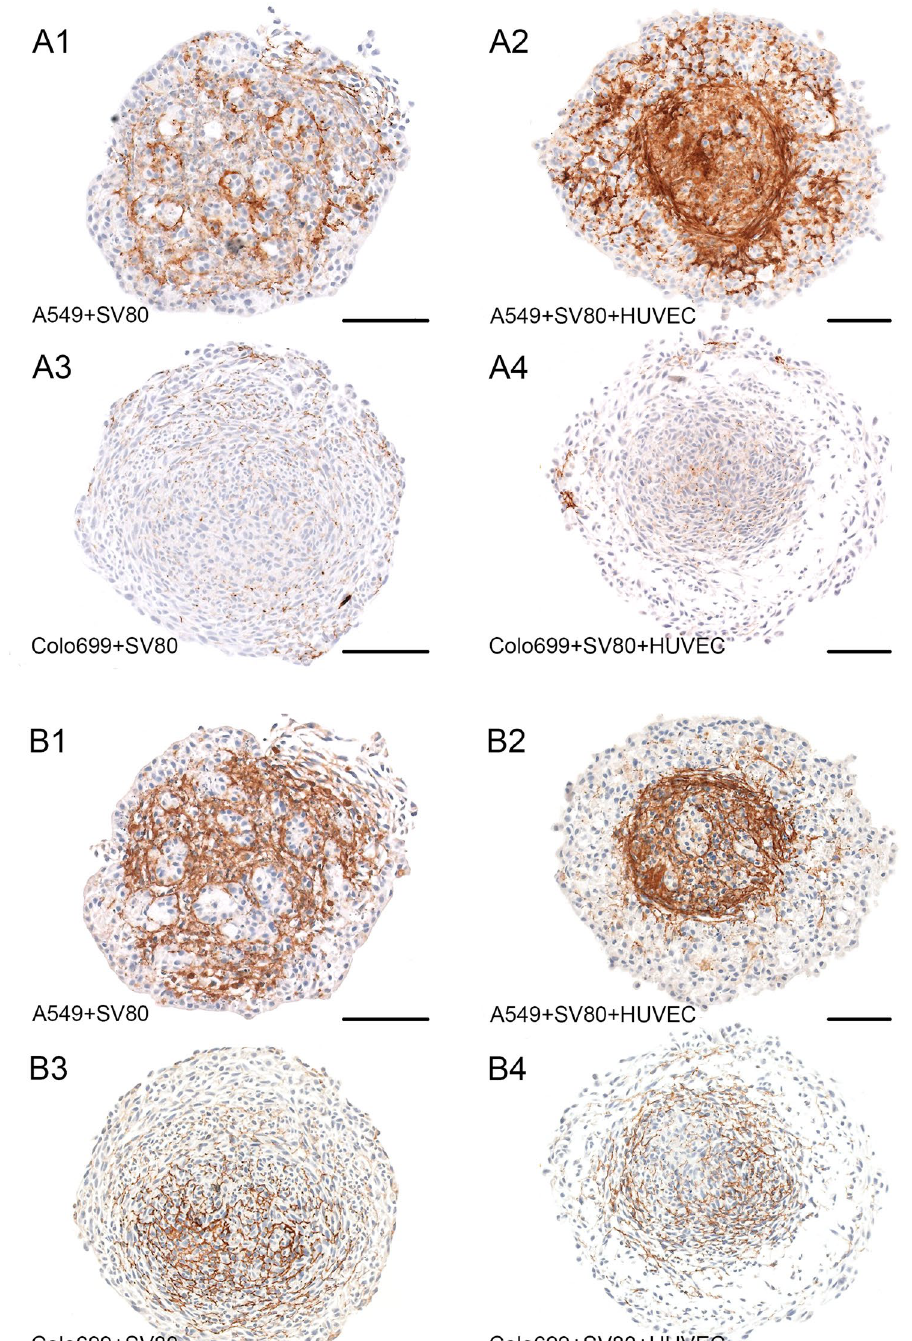
Figure 4. Production of ECM. Fibronectin A1–A4, Collagen VI B1–B4, Bar: 100 µ m. Production of Fibronectin and Collagen VI was observed in all microtissues that consisted of both cancer cells and stromal cells. High secretion of ECM was displayed around the core and in areas where stromal cells predominantly formed the